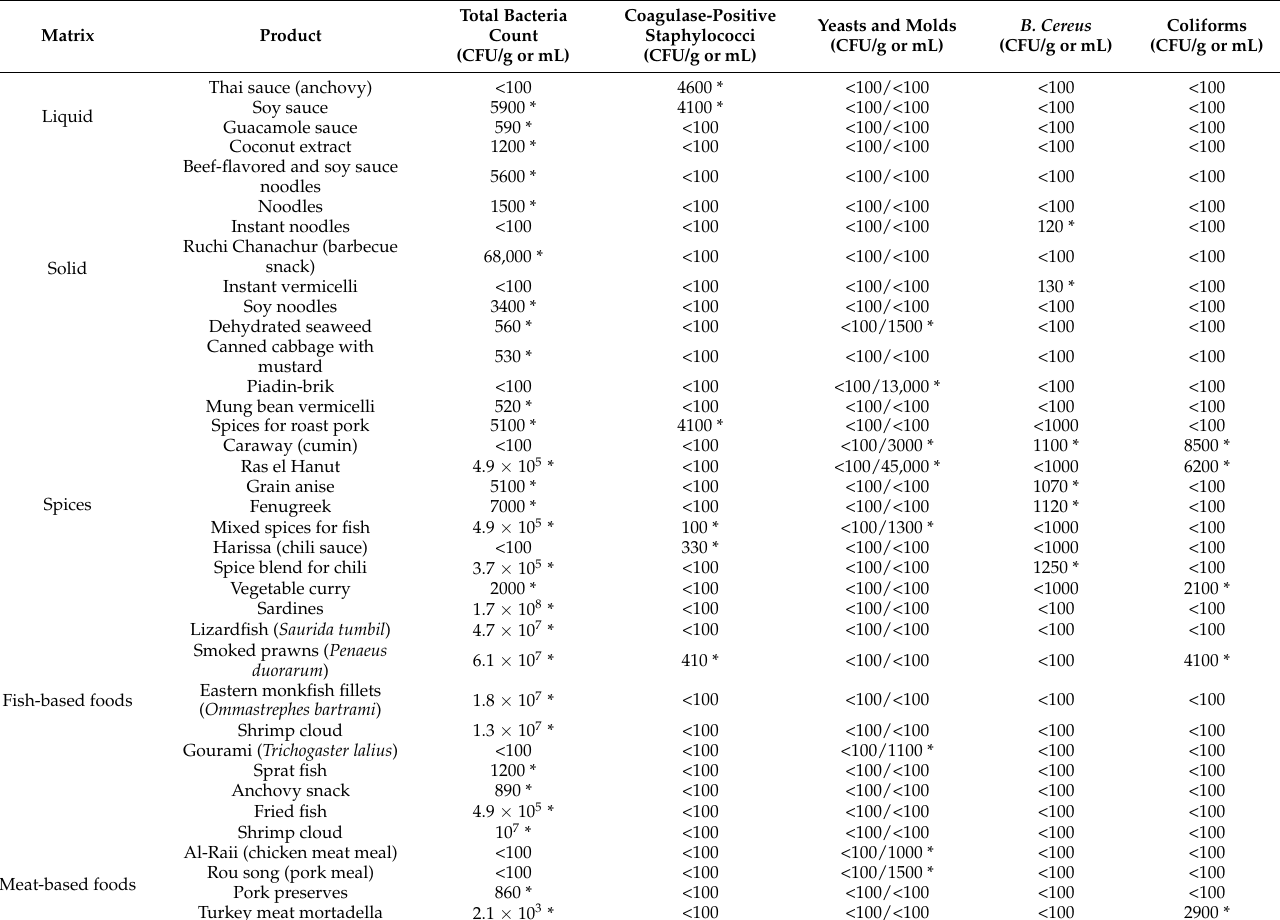
Table 5. Microbiological analyses of food